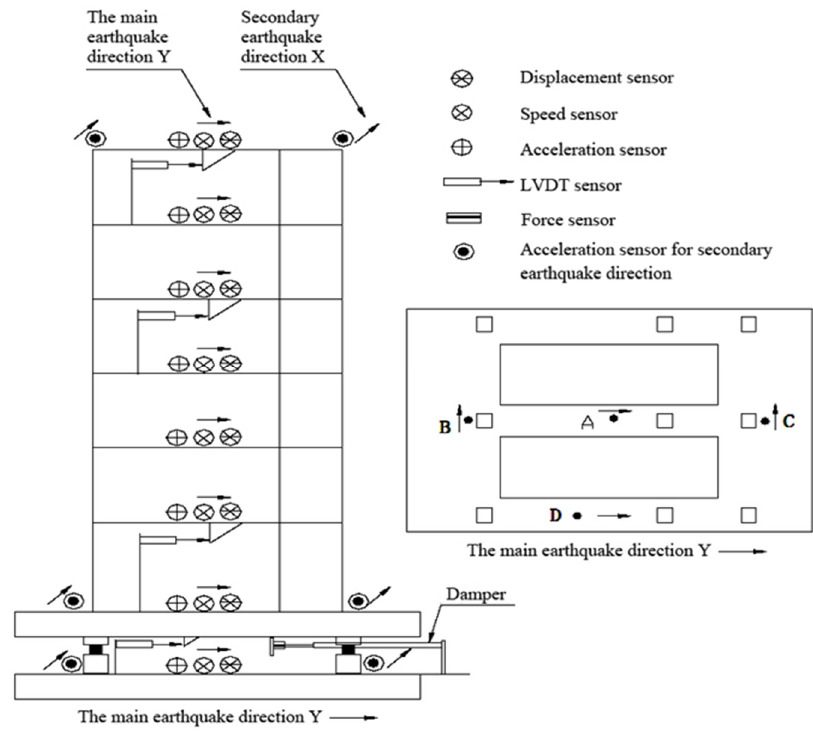
Figure 8. Sensors allocation scheme.